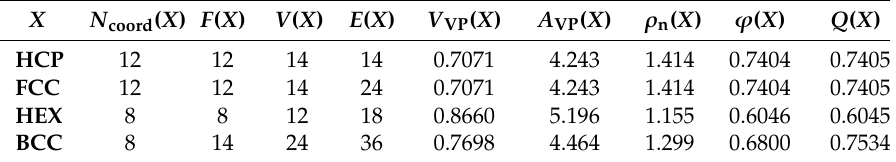
Table 5. Statistics of the Voronoi polyhedron of perfect, reference 3-D crystal X : coordination number N coord ( X ), number of faces F ( X ), vertices V ( X ) and edges E ( X ), volume V VP ( X ), surface area A VP ( X ),